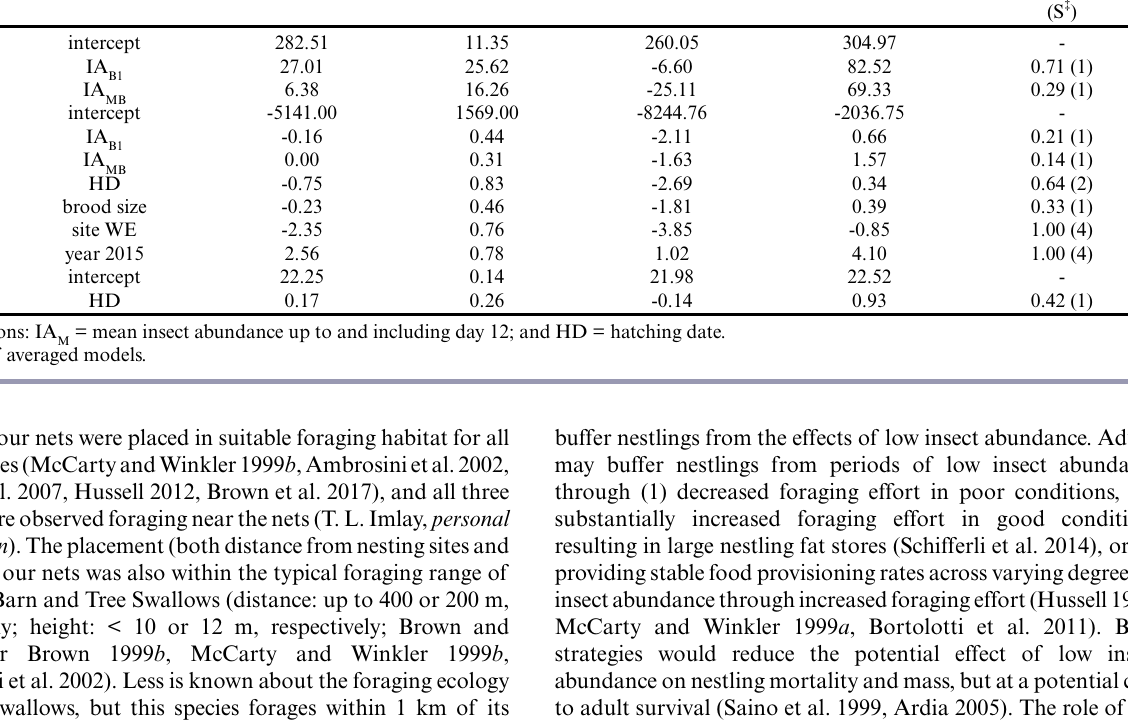
Table 6 . Averaged model coefficients with adjusted SE and confidence intervals (CI) from the best-fit models for Barn ( Hirundo rustica ), Cliff ( Petrochelidon pyrrhonota ), and Tree Swallow ( Tachycineta bicolor ) nestling mass.